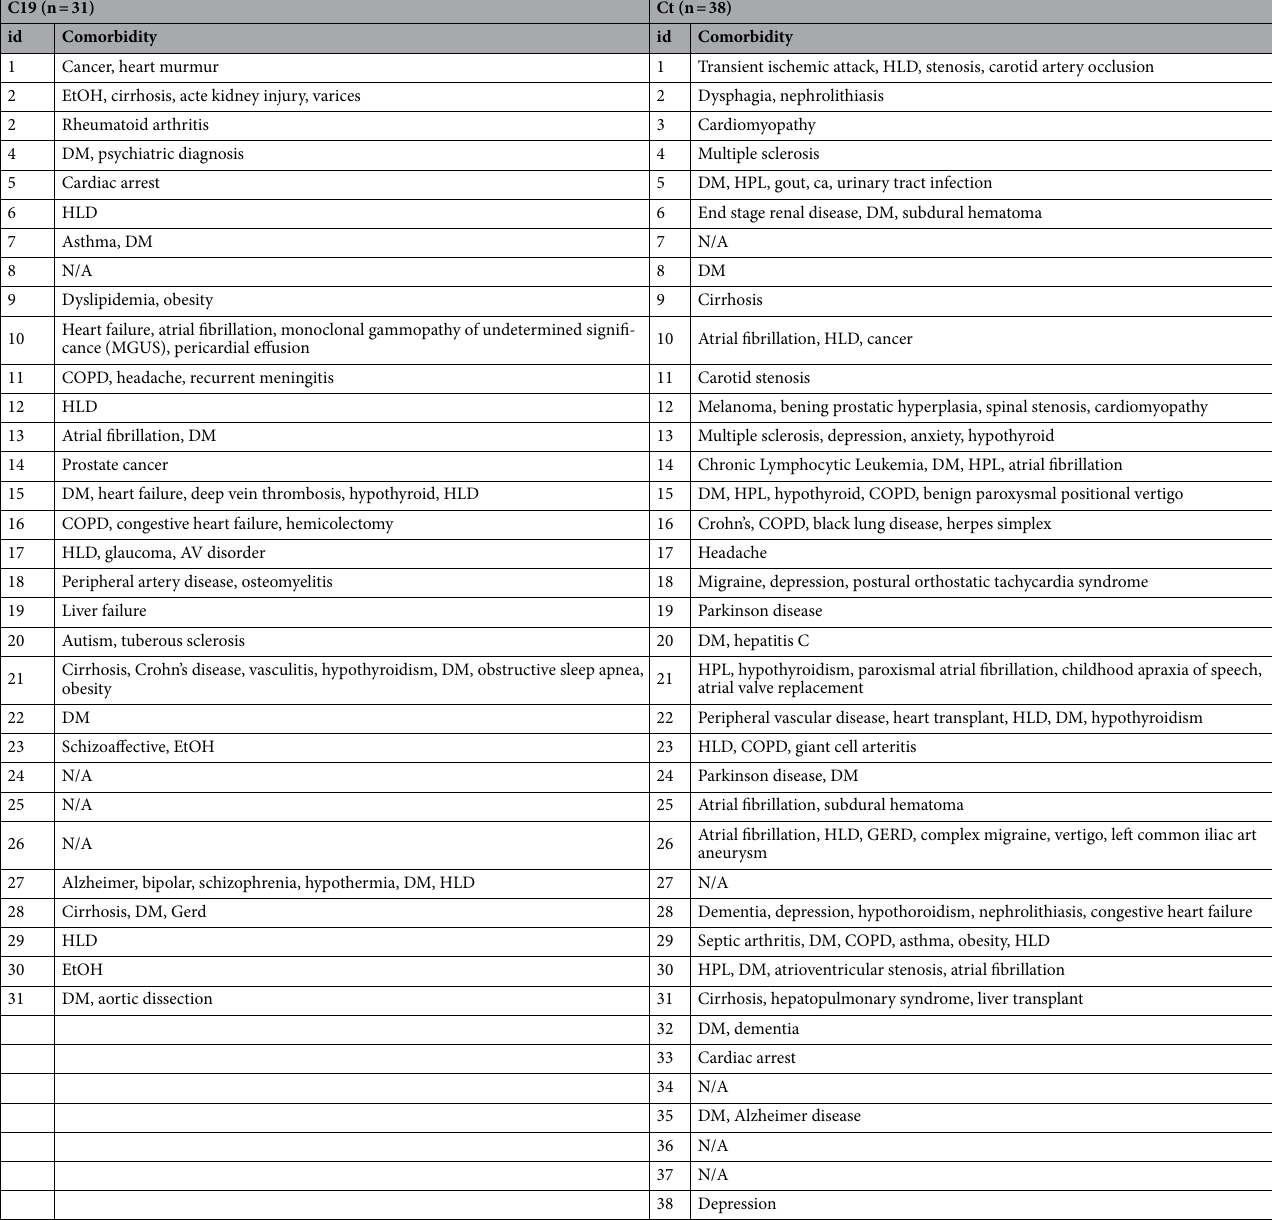
Table 4. Summary of clinical comorbidity for each patient. DM Diabetes mellitus, HLD Hypersensitivity lung disease, HPL